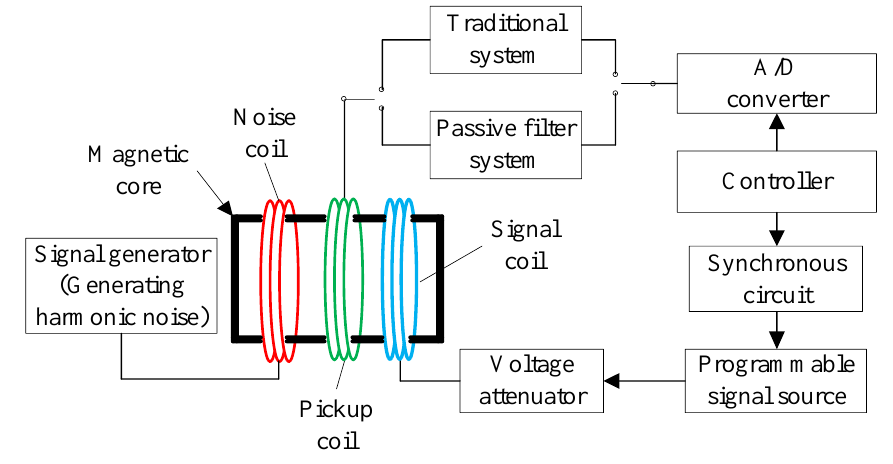
Figure 14. Schematic diagram of the test in the laboratory.